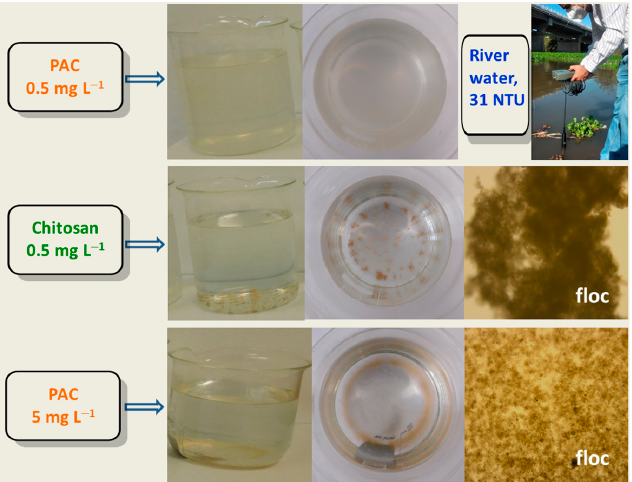
Figure 9. Turbidity reduction in water samples from the Culiacán River using chitosan and com- mercial poly(aluminum chloride) (PAC). Images were captured using a digital camera and a light microscope (magnification 10 × ) after flocculation trials. The images were taken in the Environmental